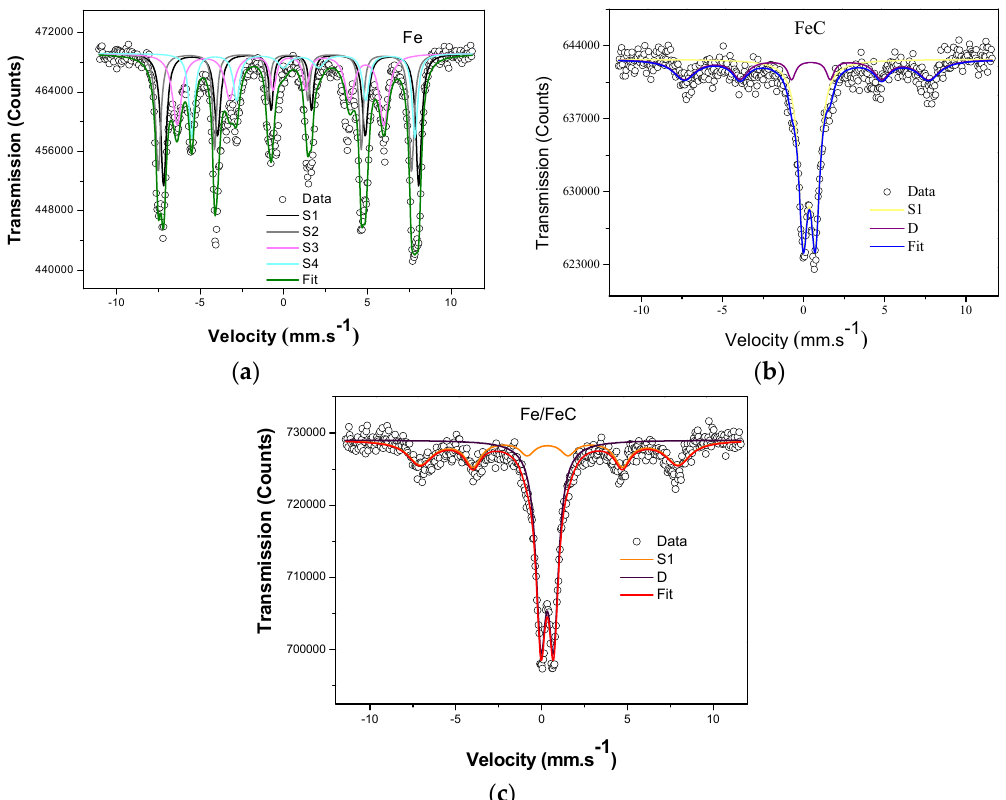
Figure 5. Fitted room temperature Mössbauer spectra of the samples studied ( a ) Fe, ( b ) Fe / C and ( c ) Fe / FeC. The letters S and D represent the sextet and doublets of the curves.